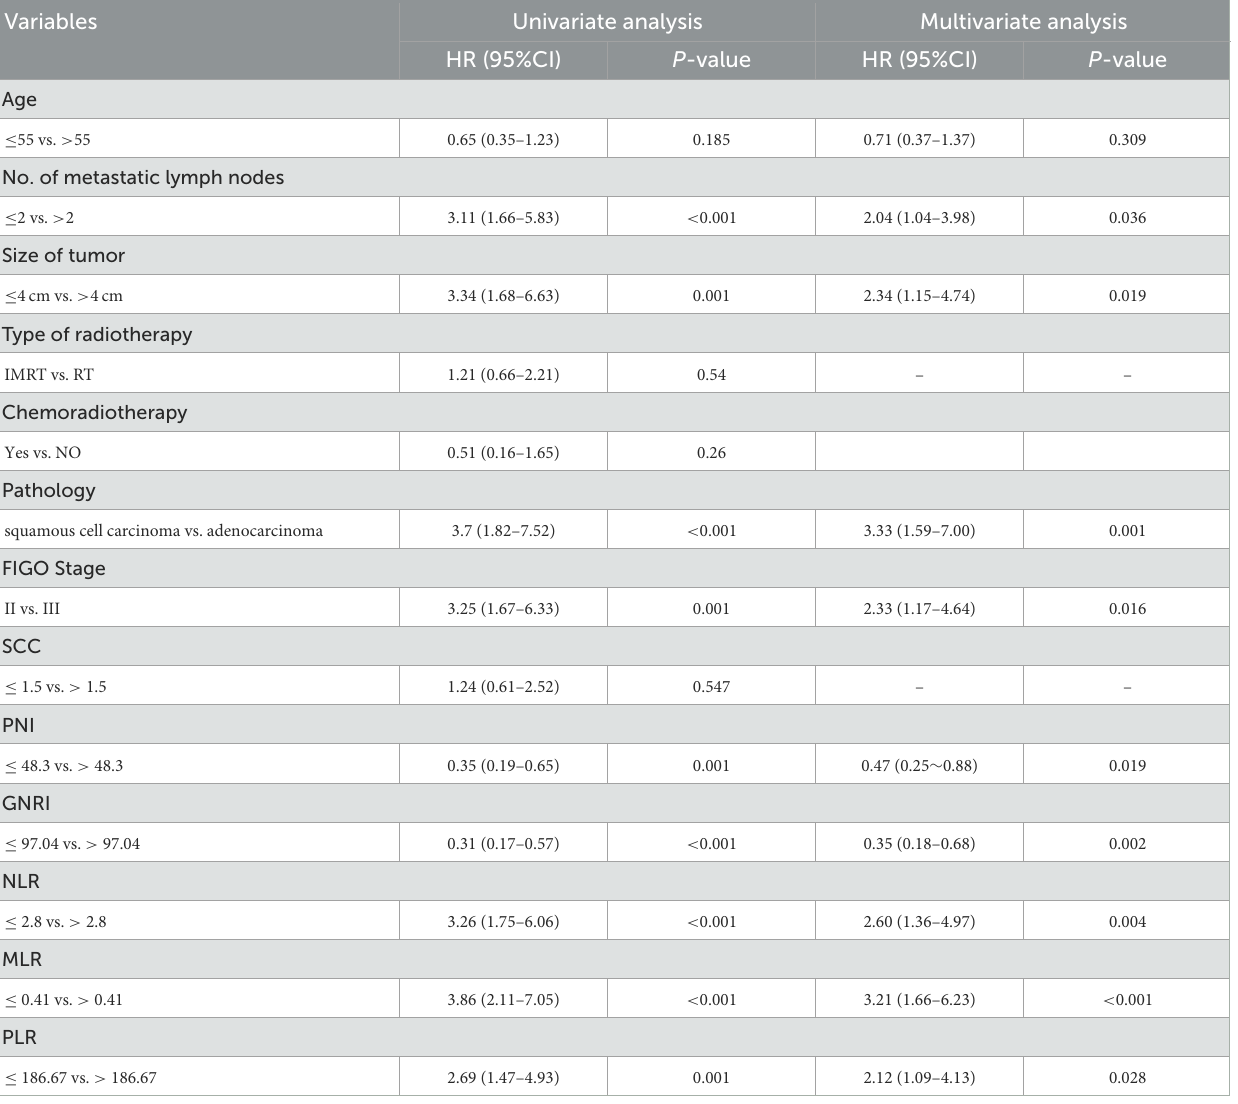
TABLE 2 Univariate and multivariate analysis for overall